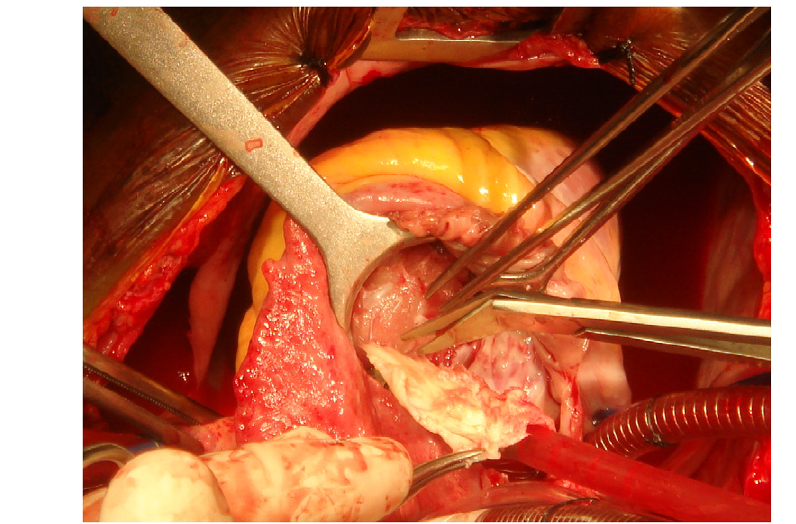
Figure 5. Intraoperative image of the surgical procedure to excise the thickened endocardium. Myocardium with healthy appearance is seen underneath the excised